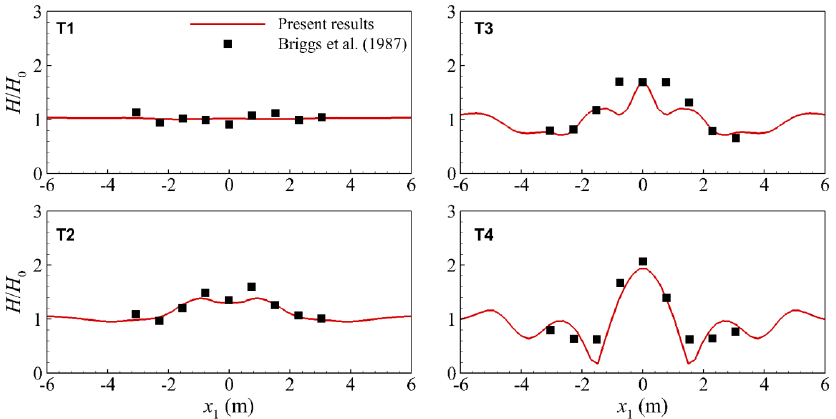
Figure 6. Comparison between numerical results (red lines) and experimental measurements (black squares), for the normalized wave height H / H 0 , along the four transects shown in Figure 2, for case C2.